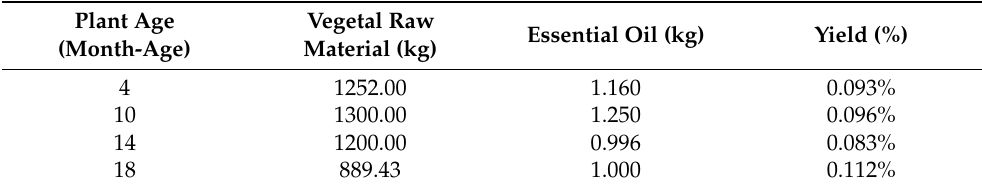
Table 2. Vegetal raw material, resulting mass and yield of essential oils produced from V. curassavica at different ages (area of 3.34